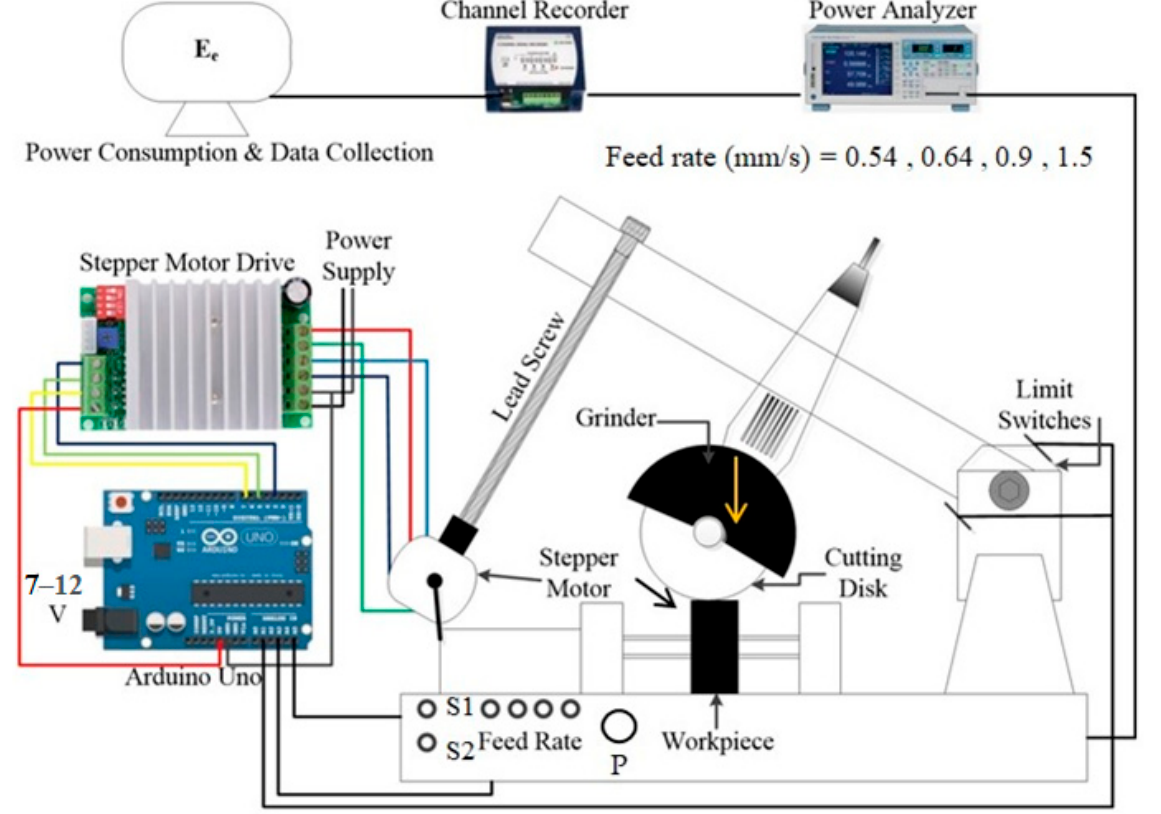
Figure 2. Machine for cut-off grinding of oxygen-free copper.